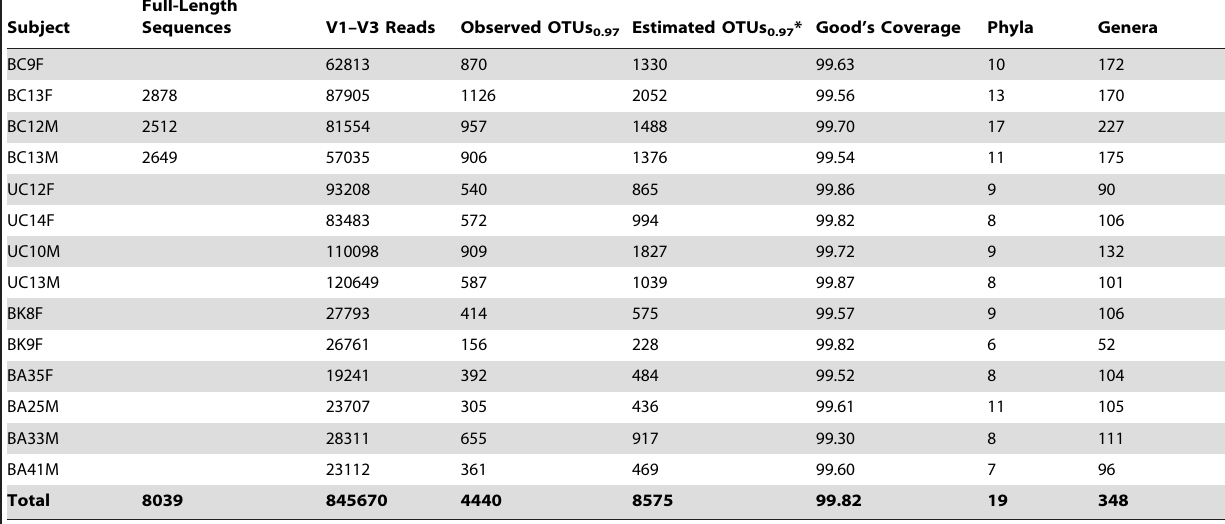
Table 2. Summary of sequencing, OTUs, coverage, and